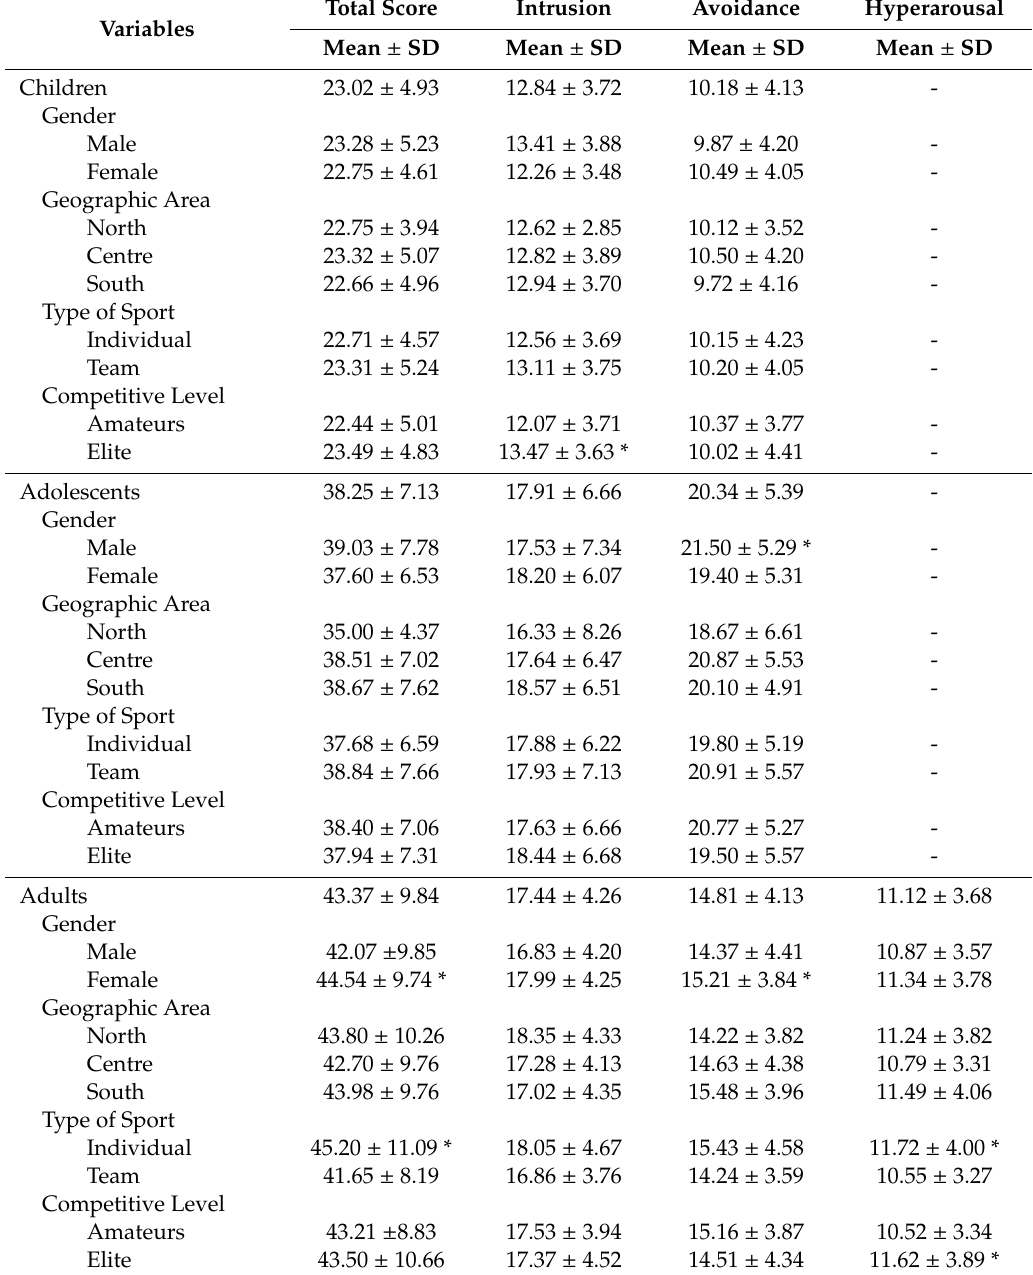
Table 3. Mean ± SD of total score and subscales